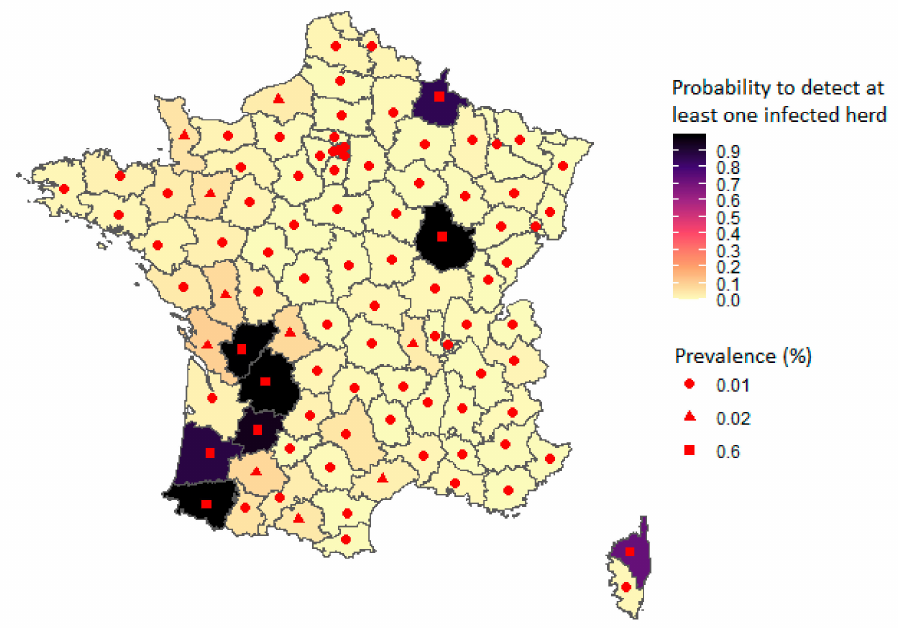
Figure 1. Estimation of the probability of detecting, via ante-mortem surveillance, at least one infected herd in the French administrative areas for a prevalence set according to the number of outbreaks recorded between 2011 and